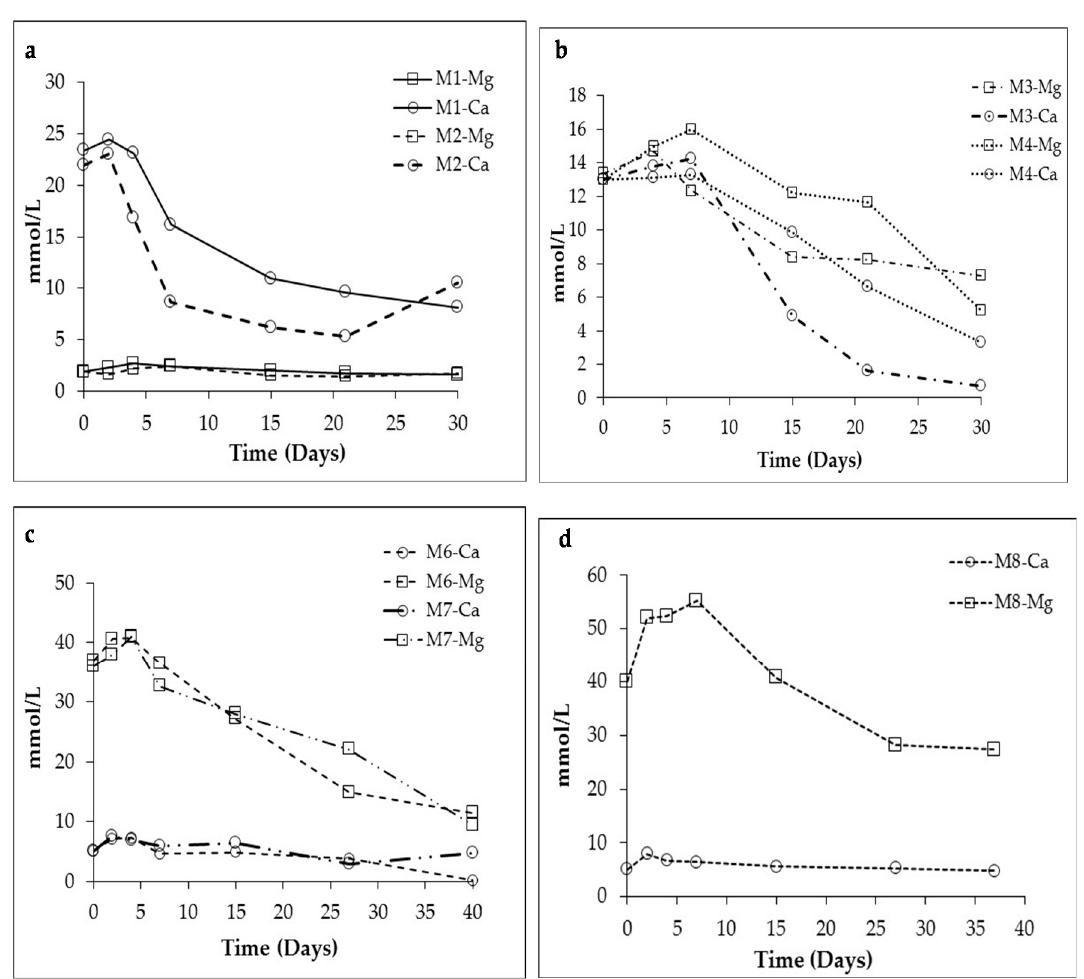
Figure 3. Evolution of Mg +2 and Ca +2 ions during the precipitation experiments: ( a ) M1-M2; ( b ) M3-M4; ( c ) M6-M7; ( d ) M8.